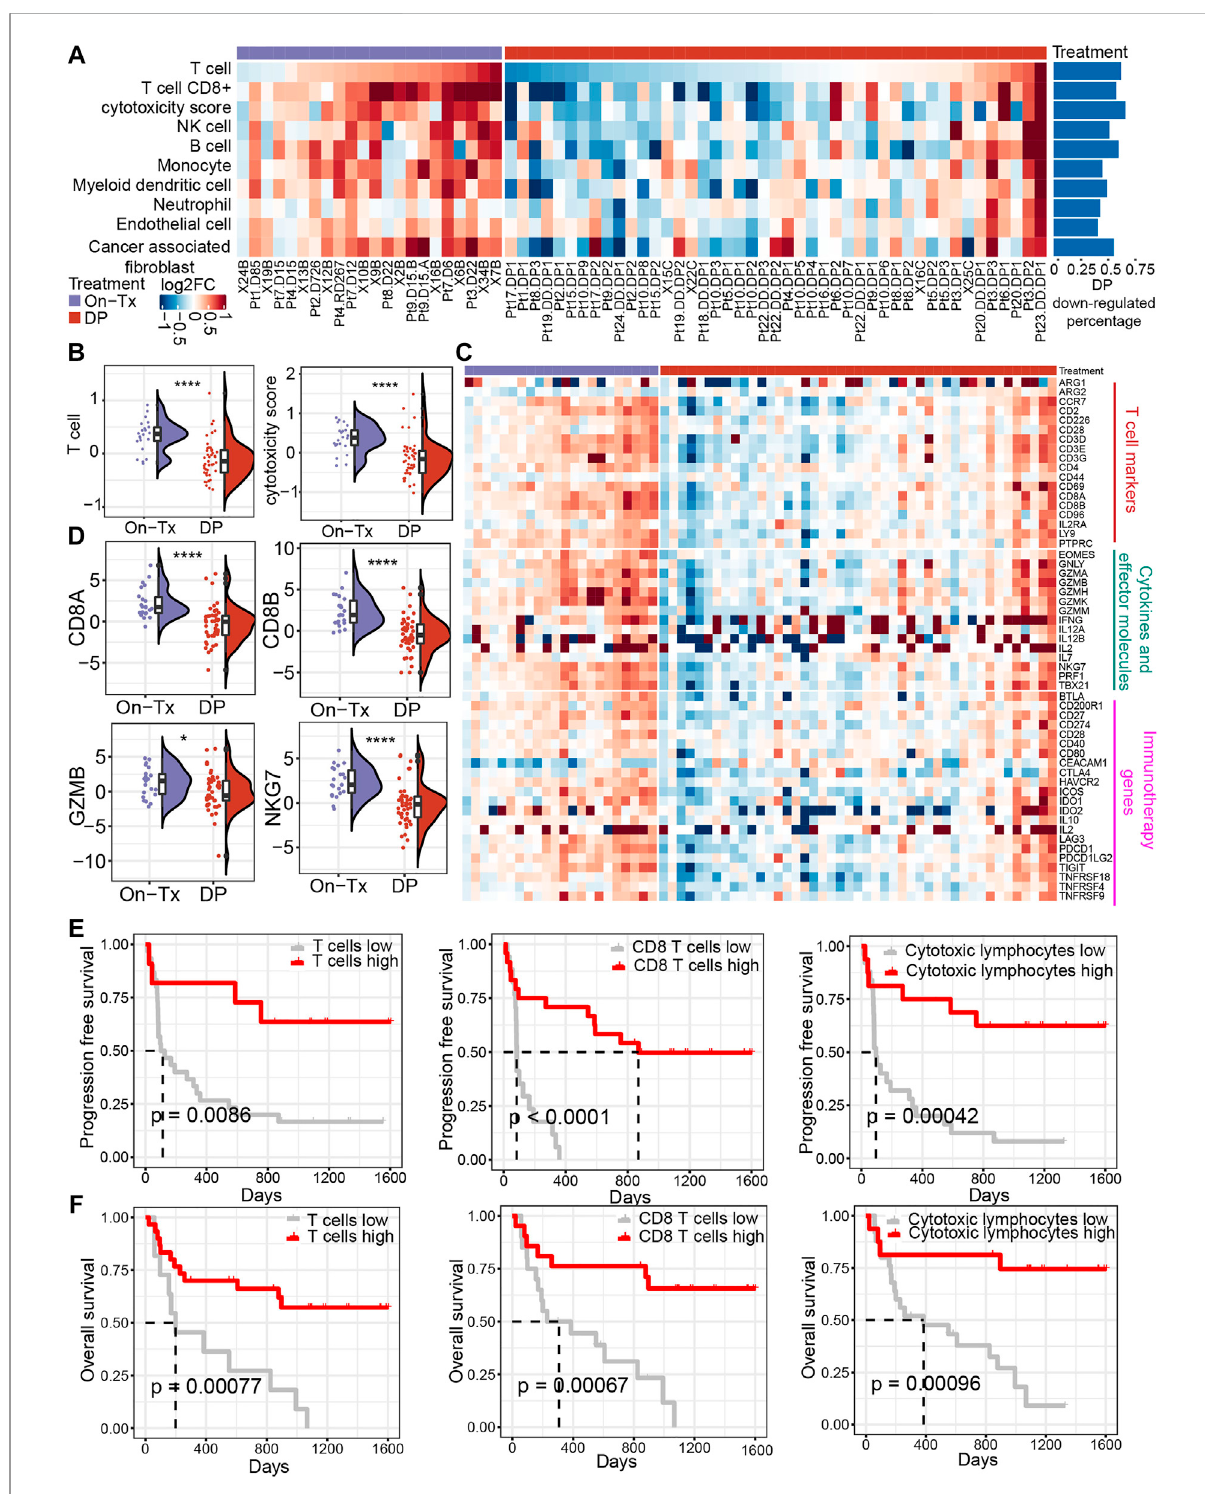
FIGURE 1 DynamicchangesintheimmunemicroenvironmentduringMAPK-targetedtherapyinmelanoma. (A) Heatmapoflog2FC expression intumor- in fi ltrating immune cells and stromal cells between MAPKi-treated and patient-matched baseline biopsies (GSE75313, GSE65185, and EGAS00001000992). The rows have been sorted according to the log2FC of the T cell. The right histogram shows the proportion of samples with downregulatedin fi ltratingcellabundanceintheresistantbiopsiescomparedtothebaselinebiopsies (B) Boxplotshowingdifferencesinlog2FC